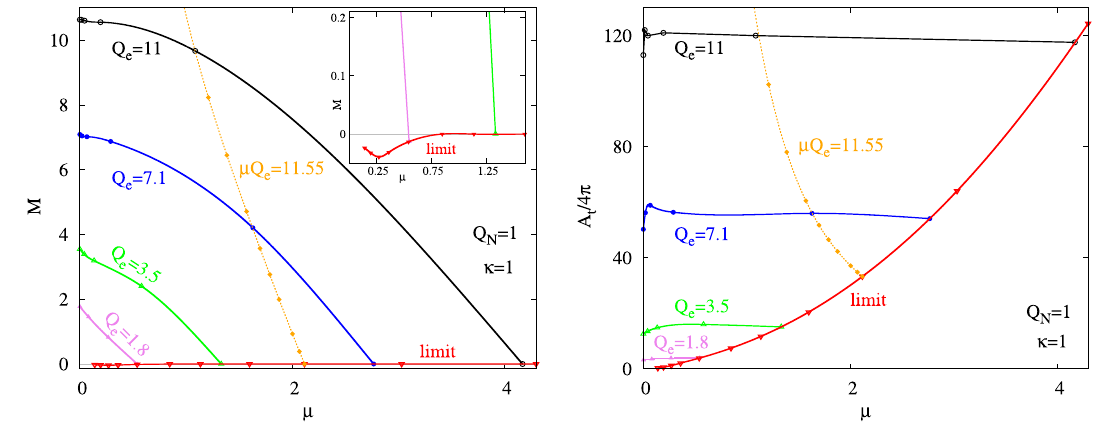
Fig. 6 (left) Mass M vs μ in Plank units for solutions with q = 0. The color curves correspond to families of solutions with fixed electric charge ( Q e = 1 . 8 , 3 . 5 , 7 . 1 , 11 in pink, green, blue and black respec- tively). In red we show the limit configurations with w ∗ = − μ . In